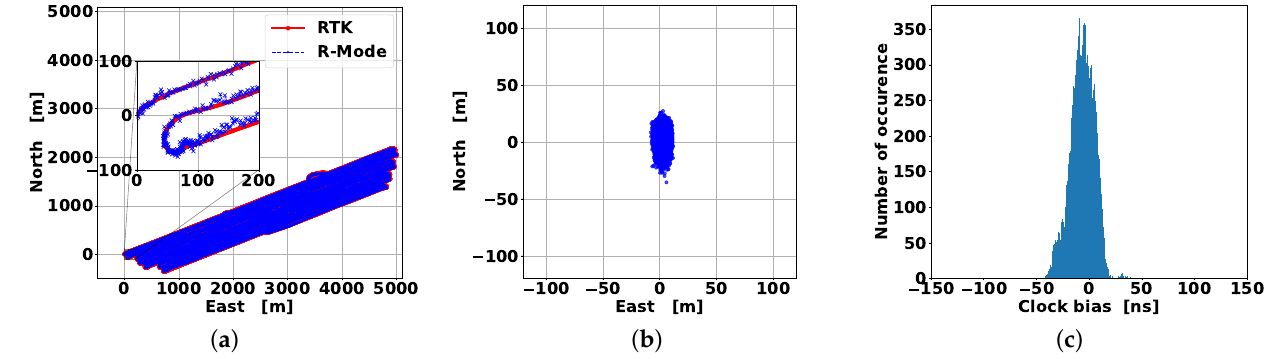
Figure 7. Daytime results. ( a ) Reference RTK (red circles) and R-Mode (blue crosses) tracks. ( b ) Scat- terplot of the R-Mode positioning error in east and north. ( c ) Histogram of the estimated receiver clock